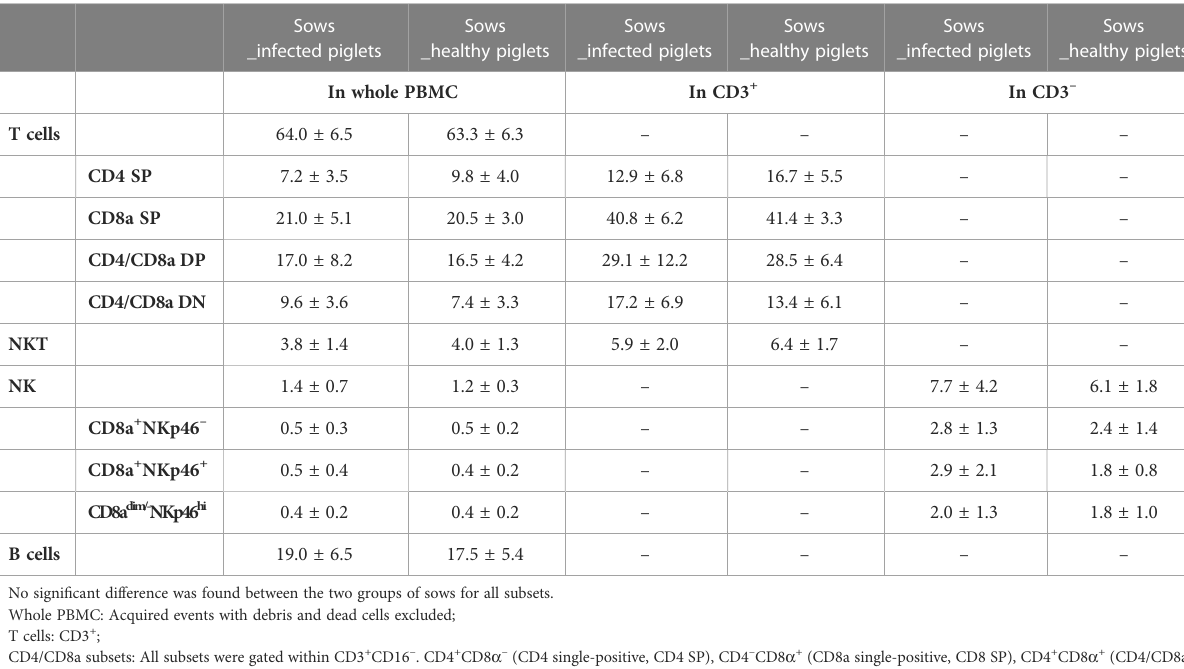
Figure 1). Upon in vitro re-stimulation with PRRSV-1 JA2 (MOI 0.1), CD4 SP and CD4/CD8 a DN T cells proliferated to a higher extent in sows that delivered healthy piglets than their counterparts delivering JA2-infected fetuses (5.2% vs 1.6% for CD4 SP, and 4.3% vs 2.3% for CD4/CD8 a DN, p < 0.05) (Figure 6). Of note, the proliferated cells (CellTrace Violet dim ) were mostly Near-IR + , namely dead cells (data not shown). This indicates a short half-life of the virus-speci fi c cells in in vitro re-stimulated cultures, possibly caused by exhaustion or activation-induced cell death (AICD) (19). By contrast, CD8 a SP and CD4/CD8 a DP as well as NKT and NK cells rarely proliferated in either group of sows (data not shown).